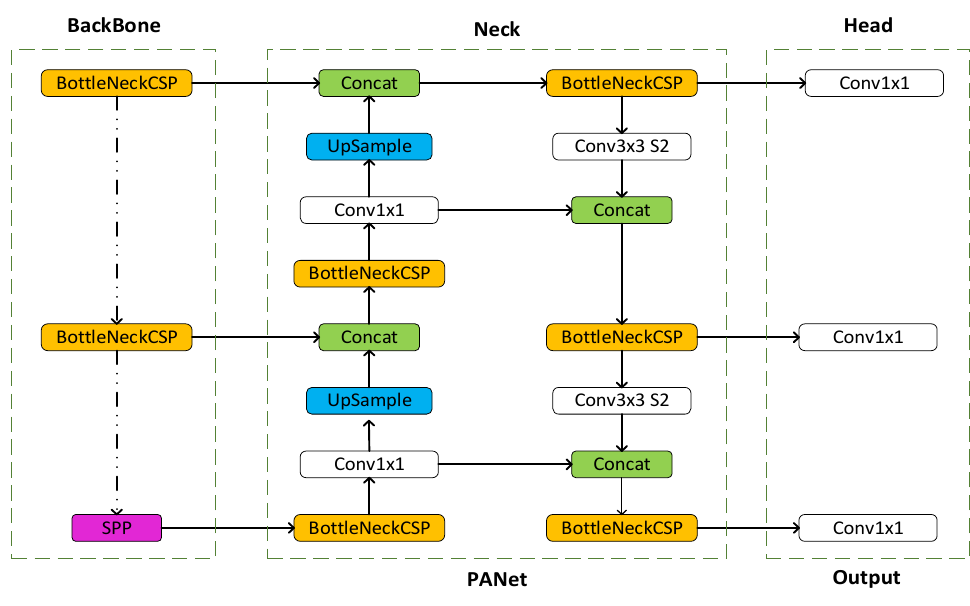
Figure 4. Network